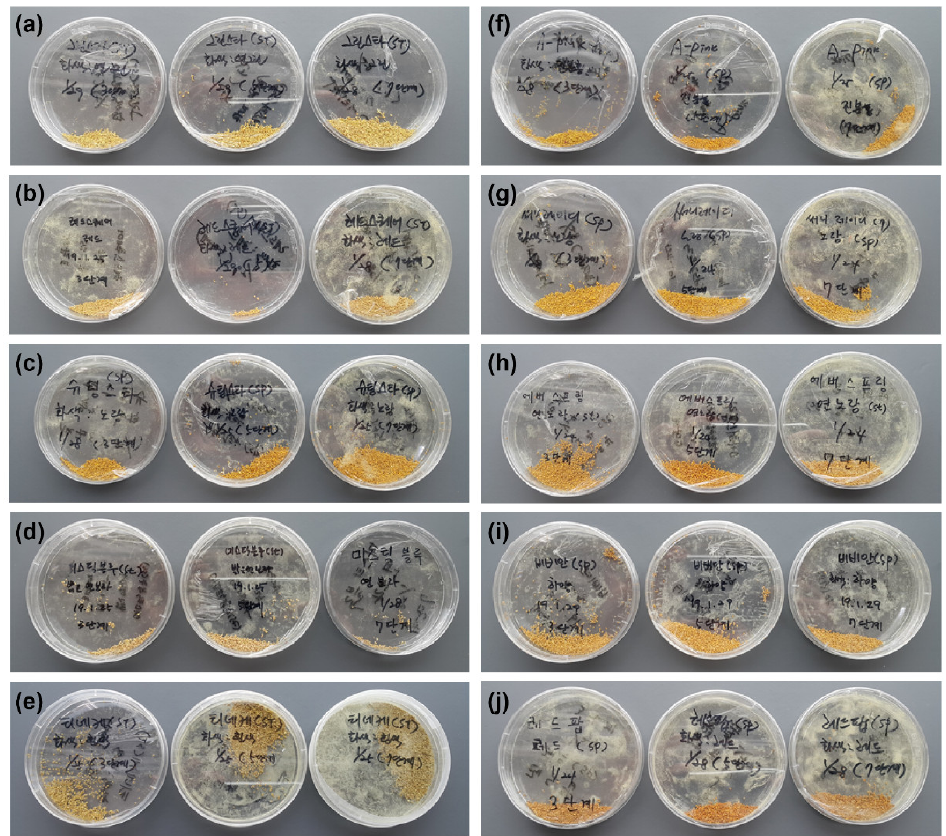
Figure 3. Comparison of pollen quantity from flowering stages 3, 5, and 7 (from the left). Standard type: ( a ) ‘Green Star’, ( b ) Red Square’, ( c ) ‘Shooting Star’, ( d ) ‘Mystic Blue’, ( e ) ‘Tineke’; spray type: ( f ) ‘A-Pink’, ( g ) ‘Sunny Lady’, ( h ) ‘Ever Spring’, ( i ) ‘Vivien’, ( j ) ‘Red Pop’. The normal pollen rate of the standard type was 46.4–58.9% at the third stage of flow- ering and 47.2–58.1% at the fifth stage. The spray-type normal pollen rates were 63.1– 84.2%, 62.4–80.6%, and 65.9–83.3%, for stages 3, 5, and 7, respectively (Table 1). The ratio of the normal pollen rate of the spray type was higher than that of standard type. In the standard type, the normal pollen count increased in the following order: ‘Green Star’, ‘Tineke’, ‘Mystic Blue’, ‘Red Square’, and ‘Shooting Star’, irrespective of the flowering stage. ‘Green Star’ and ‘Tineke’ had higher normal pollen rates as flowering progressed, whereas ‘Red Square’ and ‘Mystic Blue’ had higher normal pollen rates at stage 5. ‘Shoot- ing Star’ had a higher normal pollen rate at stage 3. There was a difference in the tendency of the normal pollen rate according to the flowering stage. In the spray type, the propor- tion of normal pollen was high in the order ‘Ever Spring’, ‘Red Pop’, ‘A-Pink’, ‘Vivien’, and ‘Sunny Lady’. ‘Sunny Lady’ at stage 3, ‘A-Pink’ and ‘Vivien’ at stage 5, and ‘Ever Spring’ and ‘Red Pop’ at stage 7 showed high percentages of normal pollen rates, but there were no significant differences according to the flowering stage.